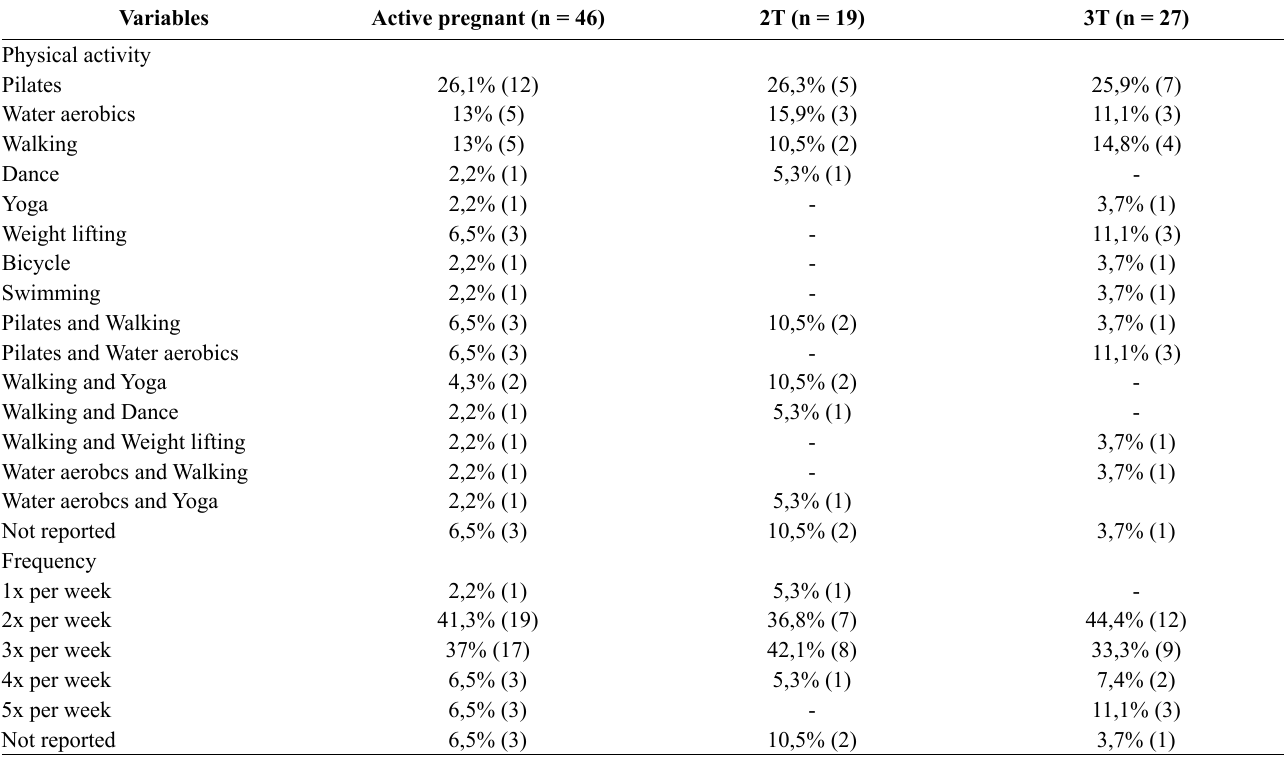
Table 2–Type and frequency of physical activities practiced by active pregnant women (n = 46)